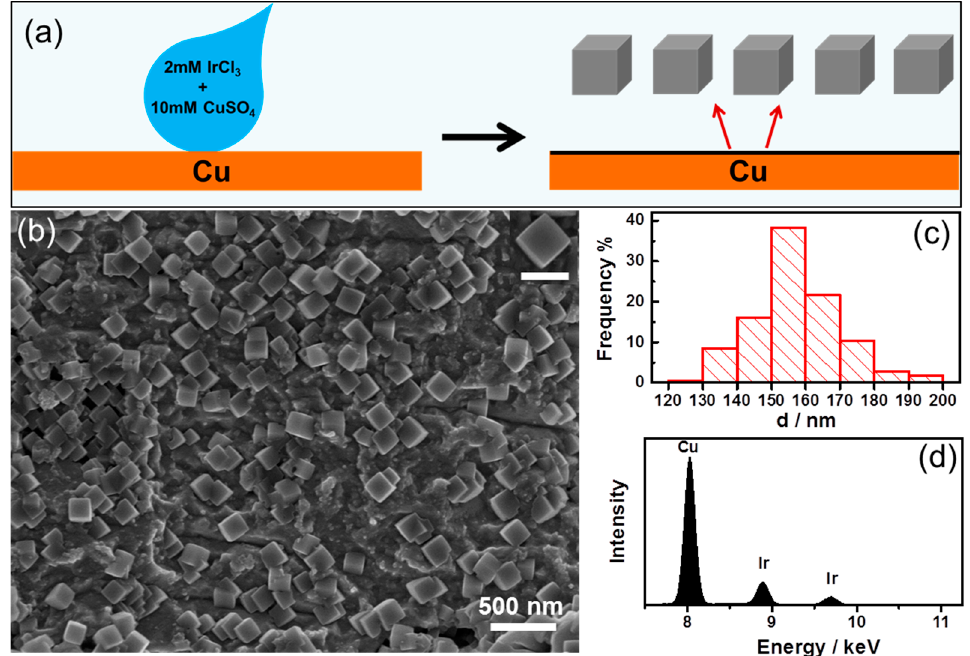
Figure 1. ( a ) Schematic illustration of metal nanoparticle deposition on Cu foil. ( b ) Overview SEM image of the Iridium nanoparticles and the inset was high magnification, and the scale bar in it is 200 nm. ( c ) Size distribution of the synthesized Iridium nanoparticles. ( d ) EDS of the Iridium nanoparticles as synthesized.